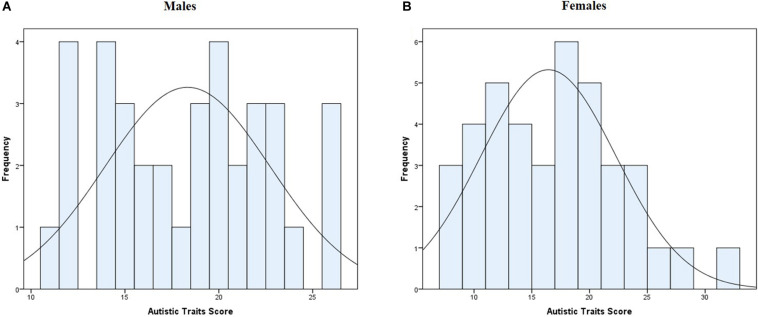
Distribution of autistic traits score panel (A) for males, panel (B) for females.